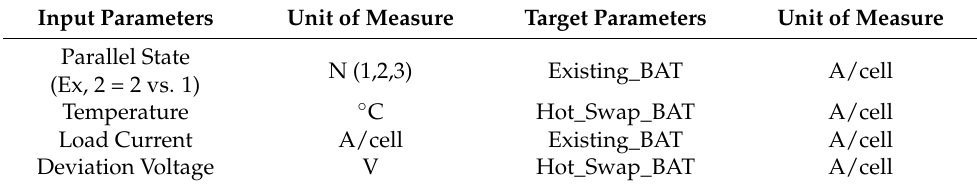
Table 5. Inputs, targets, and data type of the